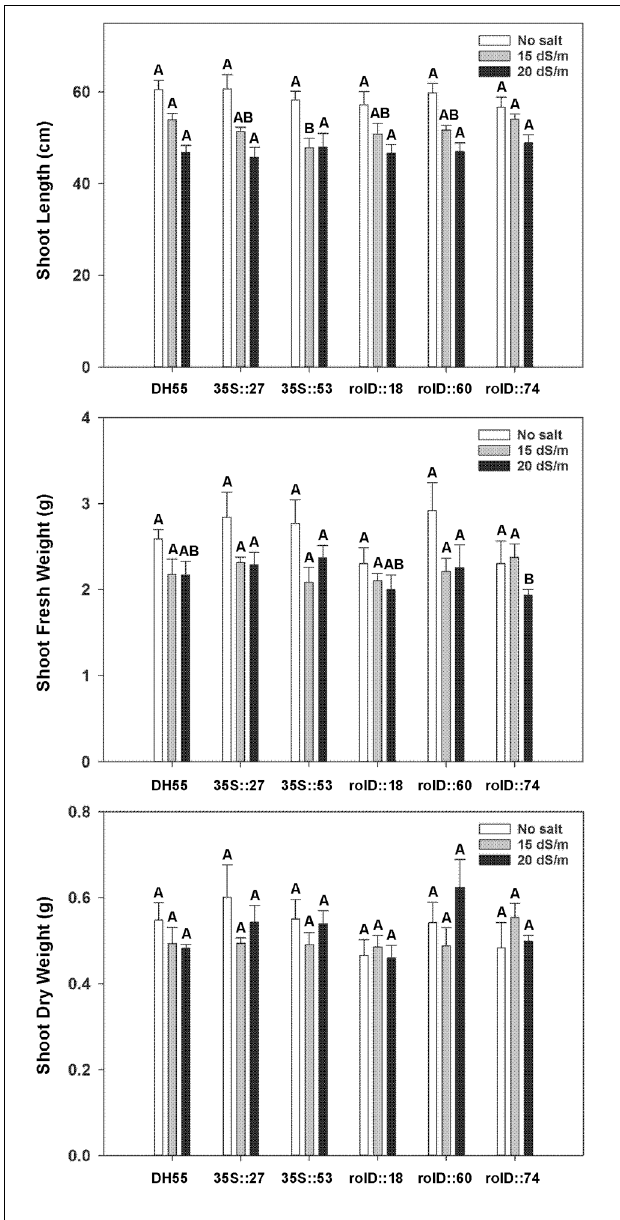
FIGURE 9 | The effect of acdS expression on shoot development of camelina plants grown in the absence, or presence of, salt (15 and 20 dSm − 1 ). Lines tested include wild-type C. sativa DH55 or independent, single insert, homozygous transgenic lines expressing the acdS gene under the control of the root-specific rolD promoter or the constitutive CaMV 35S promoter. Panels show shoot length, shoot fresh weight, and shoot dry weight 41 days after sowing. Error bars indicate standard error ( n = 10). A two- way ANOVA and Tukey post-test were used to detect significant differences between groups. Capital letters above bars indicate values that are significantly different ( p < 0.05) between lines for each salt concentration. of these substances were negatively affected in